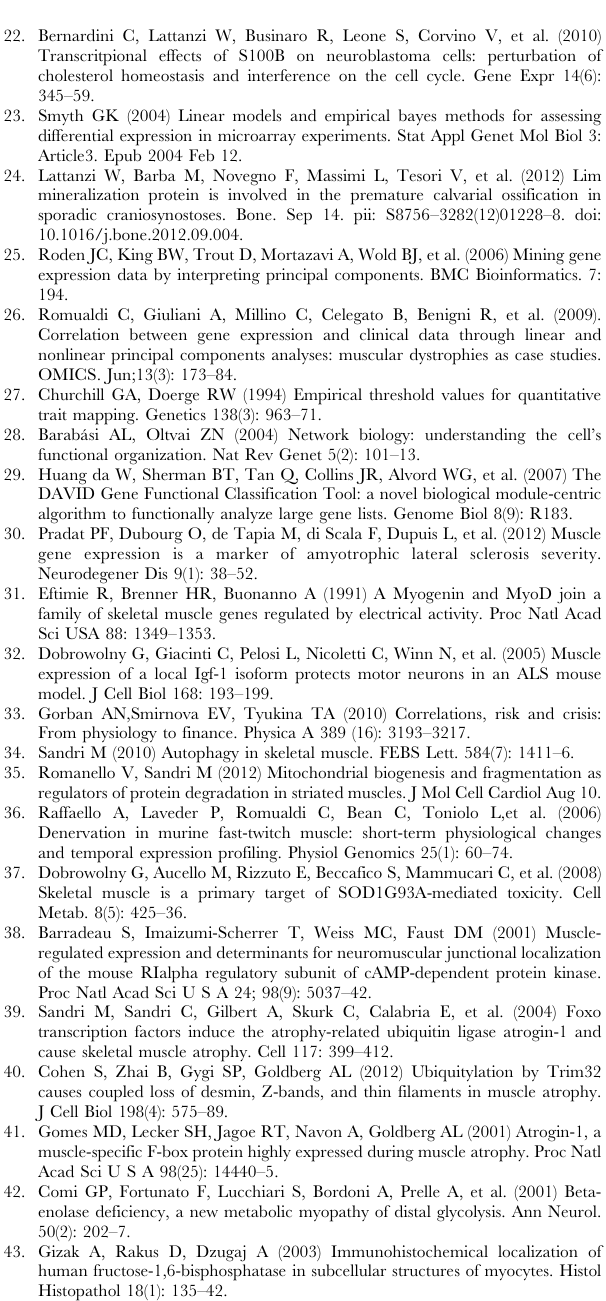
Figure S1 qPCR validation. Real-time PCR validation. Results of real-time PCR on selected genes. Relative quantity values (RQ) obtained in qPCR are compared to fold